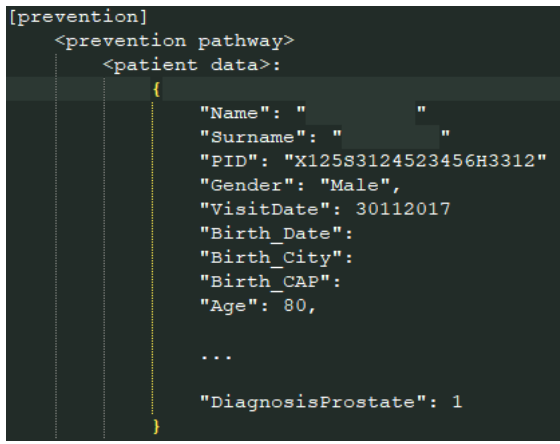
Figure 4. The MongoDB data